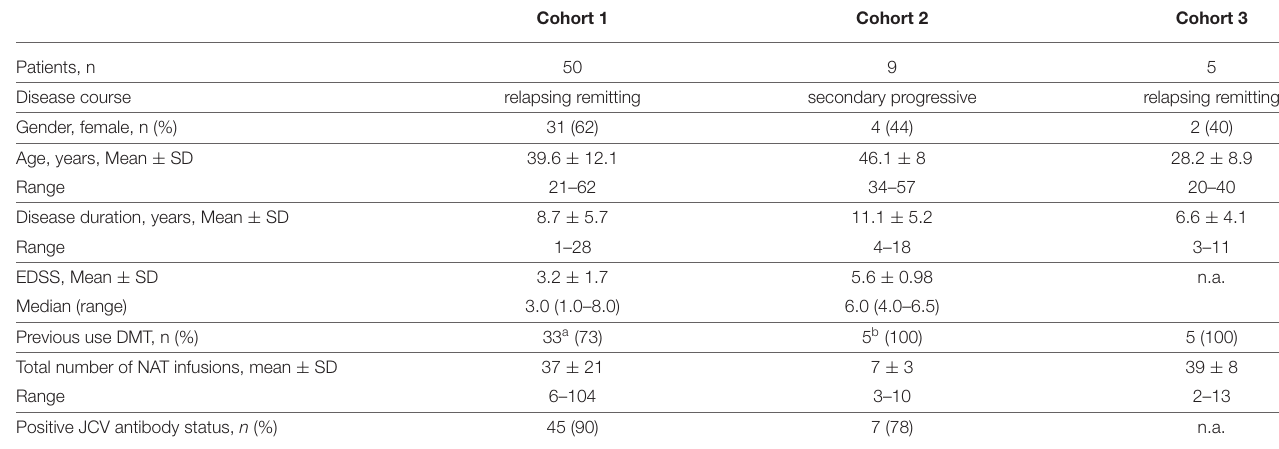
TABLE 1 | Patient characteristics ( N =